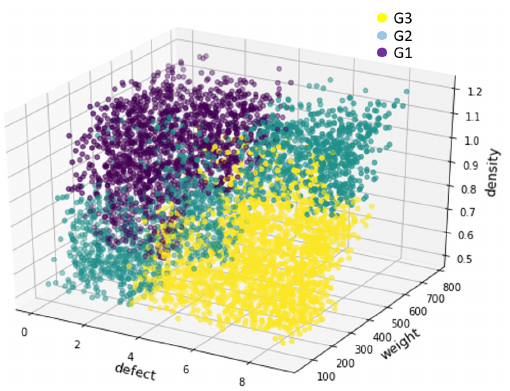
Figure 19. Visualization of training data.